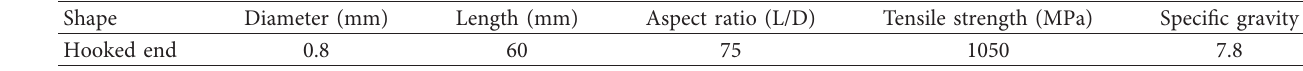
Table 1: Properties of steel fibers used in this study.